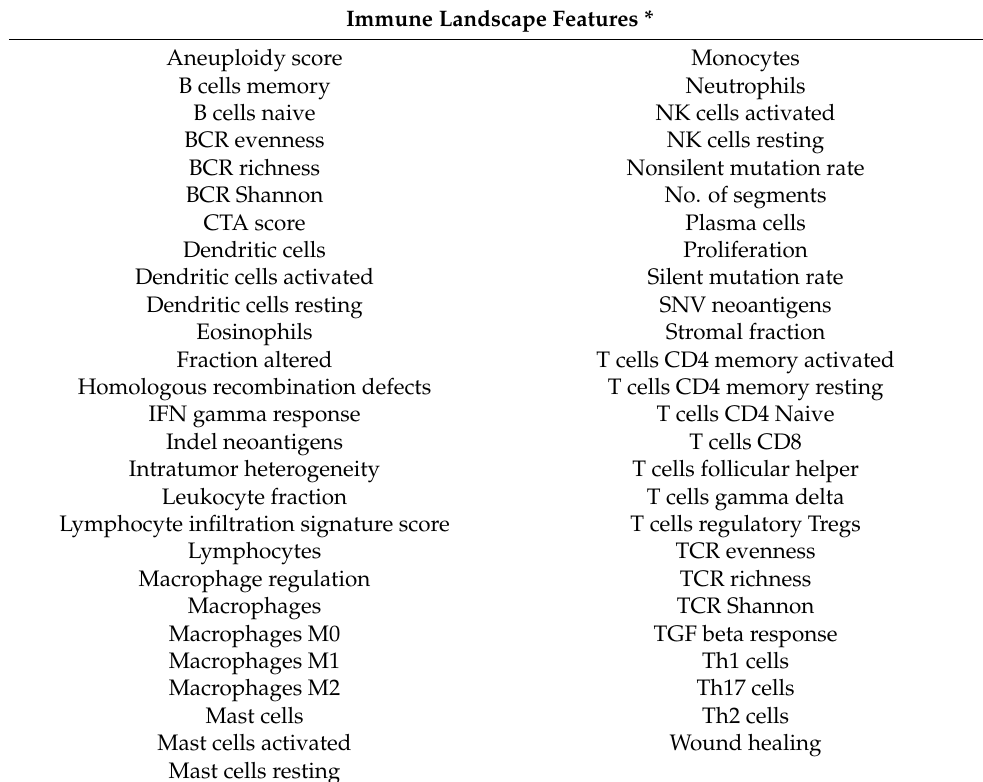
Table 2. List of the 53 immune landscape features available for analysis as part of the EBV-GCR web suite of